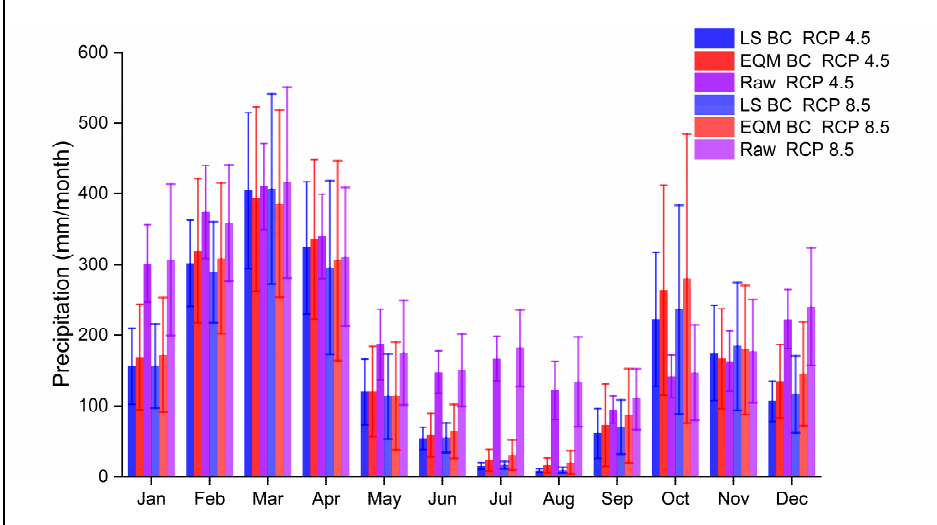
Figure 10. As Figure 5, but for the period 2070–2099.